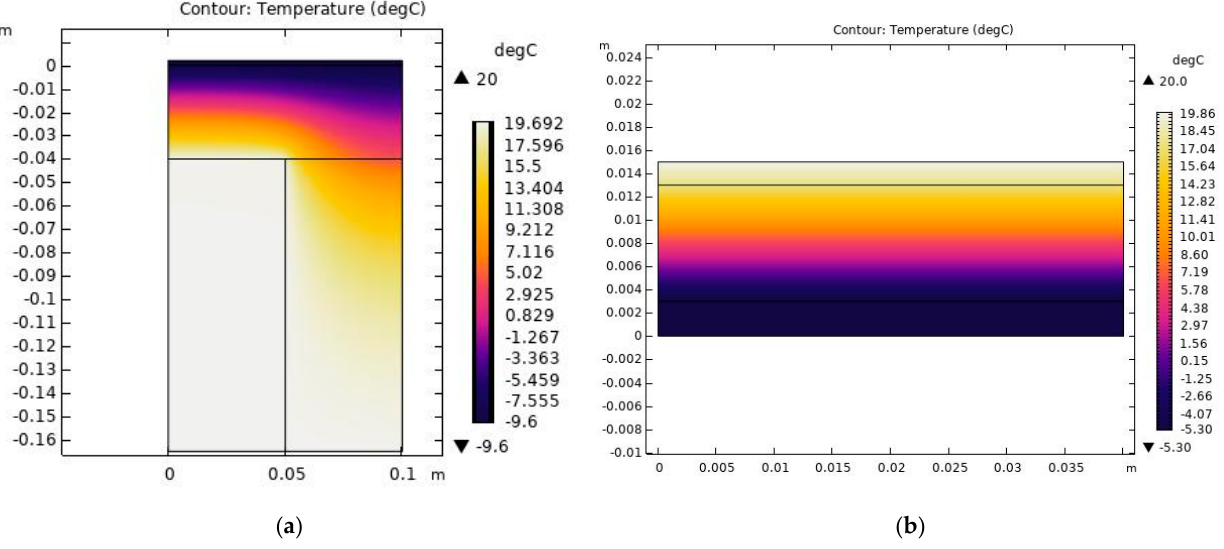
Figure 5. ( a ) Heat transfer through the roof of the bus. ( b ) Heat transfer through the floor of the bus. For the speed of 40 km/h a U value for the roof of 1.87 W/m 2 K, the heat loss is